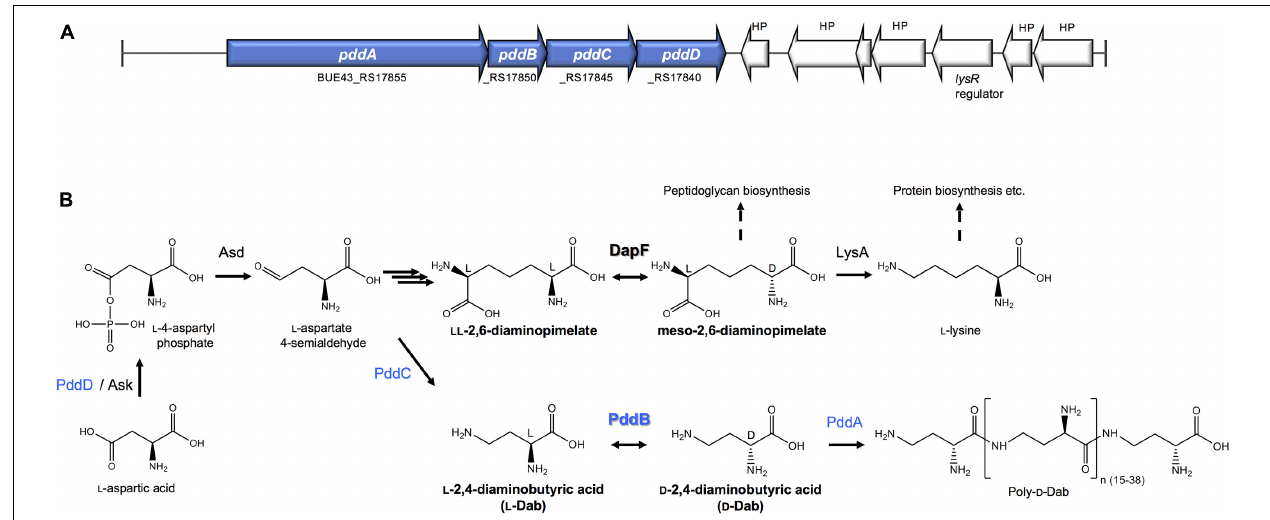
FIGURE 1 | The biosynthesis of Poly- D -Dab. (A) Periphery of the genes involved in the Poly- D -Dab biosynthesis in S. hindustanus NBRC15115. The genes coding for enzymes responsible for the biosynthesis of Poly- D -Dab (PddA to PddD) are highlighted in blue. (B) Poly- D -Dab biosynthesis, which partially shares the primary metabolic lysine biosynthetic diaminopimelate pathway. Racemization of Dab catalyzed by secondary metabolic PddB and epimerization of diaminopimelate catalyzed by primary metabolic DapF are comparably shown. Ask, aspartate kinase; Asd, aspartate-semialdehyde dehydrogenase; LysA, meso-diaminopimelic acid